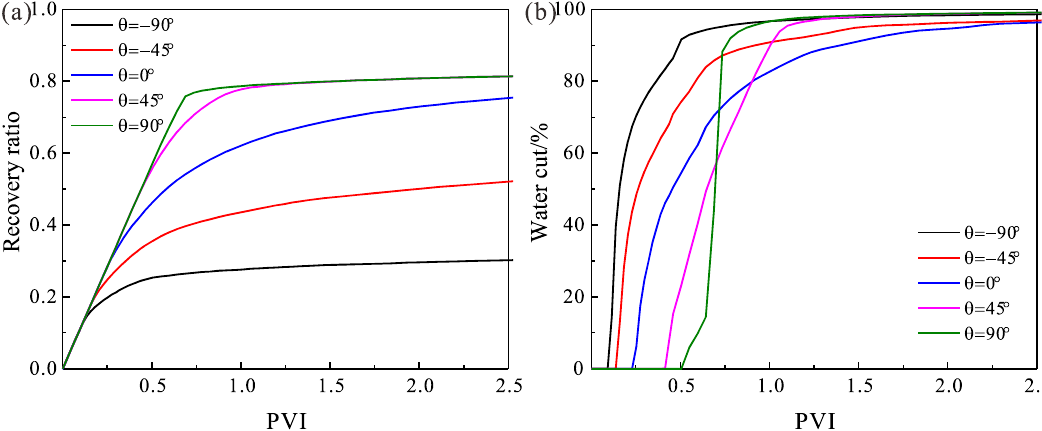
Figure 15. Numerical simulation results of the single-vug model for five different flow directions: ( a ) Oil recovery ratio and ( b ) water-cut of the production well.